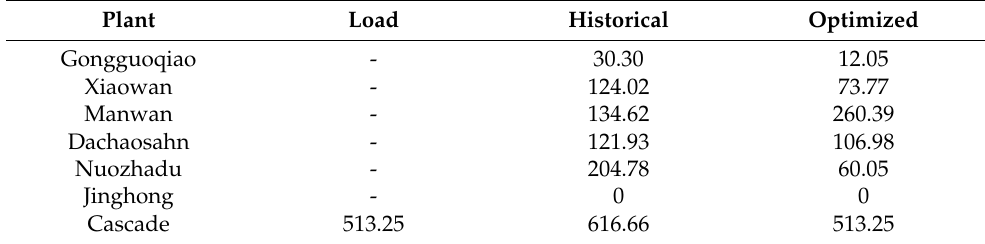
Table 4. Statistics of plant average hourly ramp.